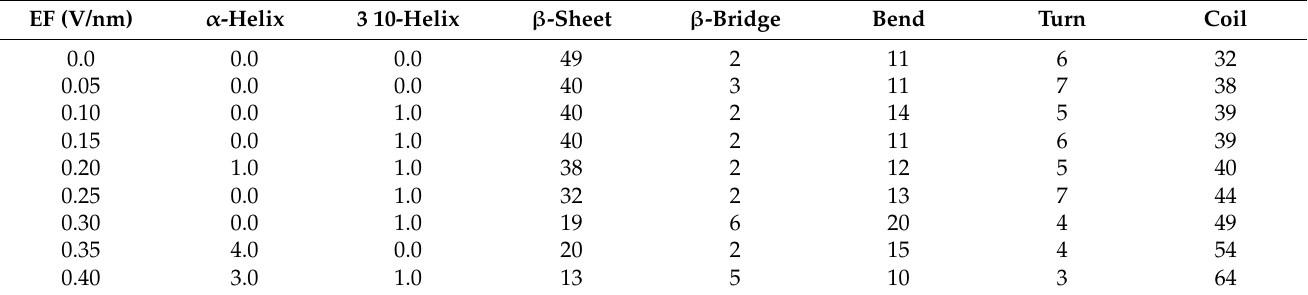
Table 1. Secondary structure analysis of the α -synuclein pentamer in each model system. The various conformation occurrences (%) of protein’s various secondary structure